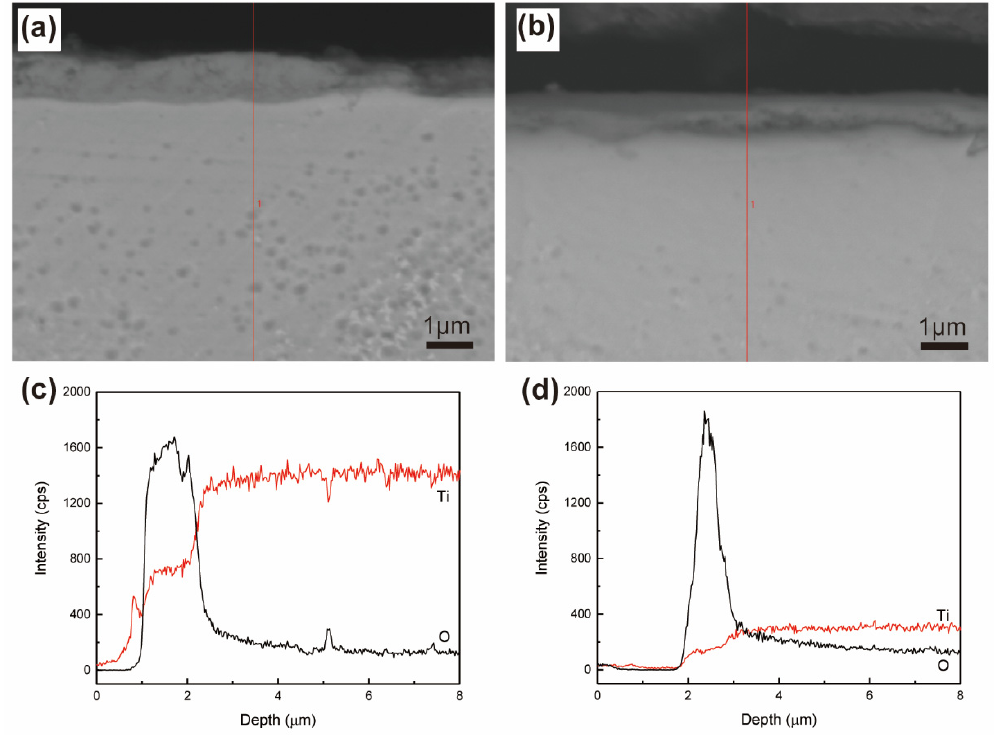
Figure 6. Cross-sectional EPMA images of titanium after IHT for 25 s ( a ) and ultrasonic-assisted IHT for 25 s ( b ). EPMA line scanning patterns of oxygen and titanium across the oxidation layer in titanium after IHT for 25 s ( c ) and ultrasonic-assisted IHT for 25 s ( d ).